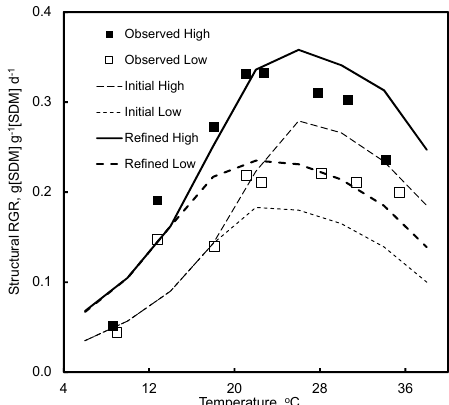
Figure 4. Relative growth rates observed for tomato seedlings over a range of temperatures under low or high light, averaging 110 or 370 µ mol[PAR] m − 2 s − 1 [30]. Observed values, indicated by symbols, were compared with predictions, lines, from initial and refined versions of the dynamic model.